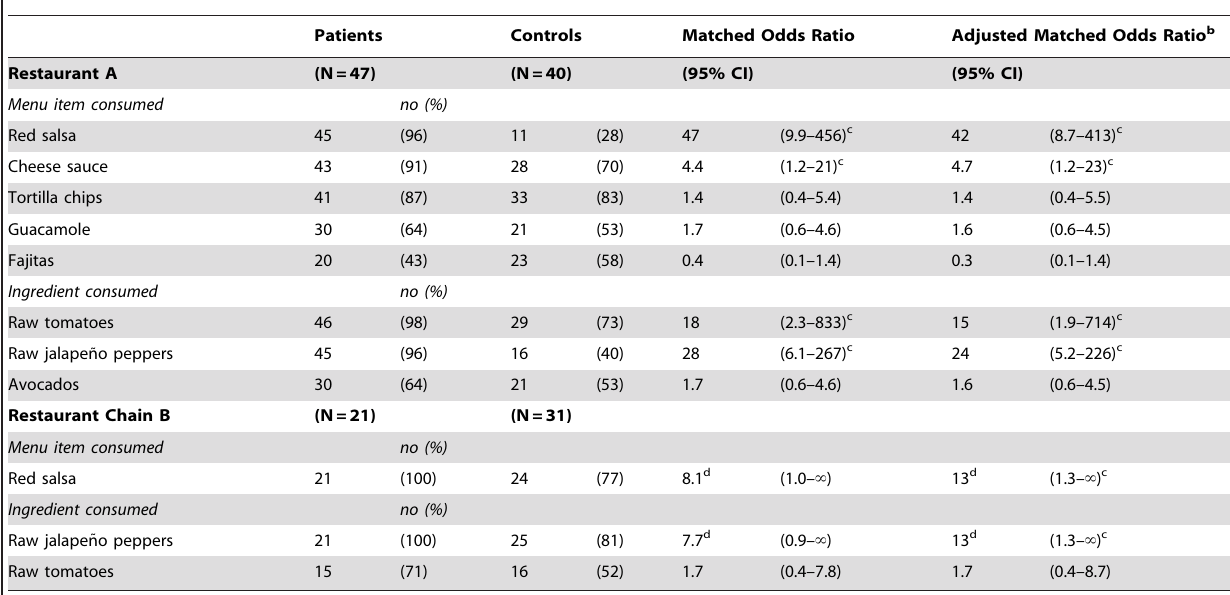
Table 1. Consumption of selected food items by case-patients and controls by restaurant cluster. a